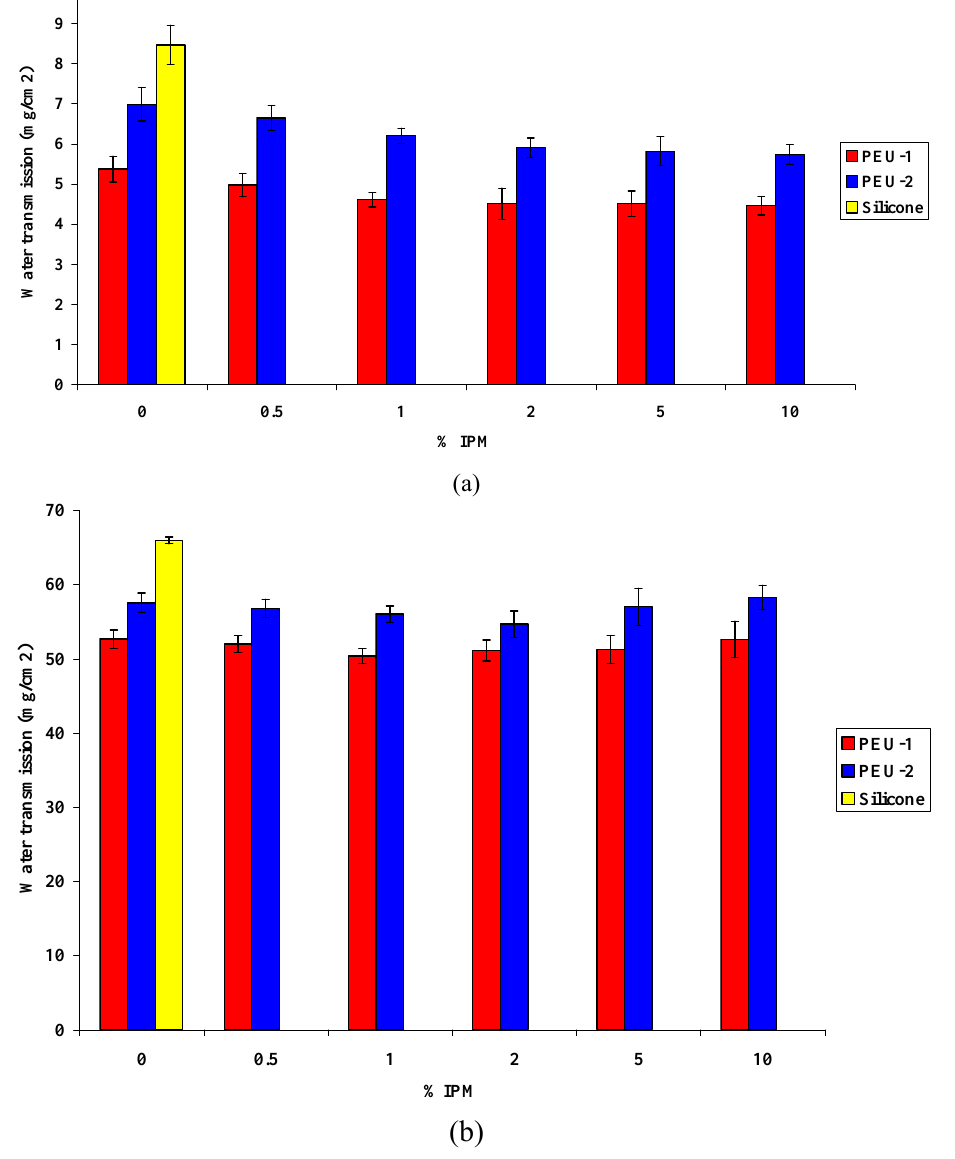
Figure 5. Water transmission through IPM modified membranes in liquid water at 37 °C, (a) after 24 hours; (b) after 7 days immersion in deionised